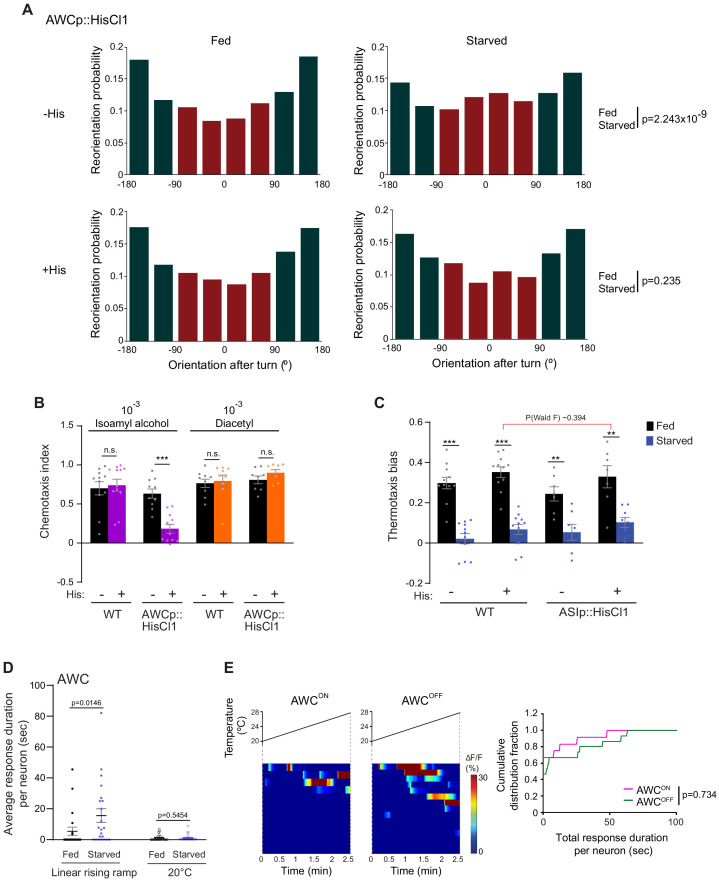
Inhibition of AWC temperature responses restores negative thermotaxis in starved animals.(A) Histograms of movement orientation following a turn in animals expressing HisCl1 in AWC in the absence or presence of histamine on the assay plate. Data are from Figure 2A. Tracks from 8 assays of 15 animals each were categorized into bins of 45°. Red and green bars indicate orientation toward the warmer/orthogonal or cooler side, respectively. p-values were derived using the Mardia-Watson-Wheeler non-parametric test for circular data. (B) Mean chemotaxis index of animals of the indicated genotypes to a point source of the odorants isoamyl alcohol or diacetyl. Chemotaxis index is defined as (number of animals at the odorant) – (number of animals at the control)/total number of animals. Assays were performed in the absence or presence of 10 mM histamine on the assay plate as indicated. Each dot represents a biologically independent assay of ~100 animals each. Errors are SEM. *** indicates different from fed (Student’s t-test); n.s. – not significant. (C) Mean thermotaxis bias of fed and starved wild-type and transgenic animals expressing HisCl1 in ASI under the srg-47 promoter in the presence or absence of 10 mM histamine on the assay plate. Each dot represents the thermotaxis bias of a biologically independent assay comprised of 15 animals. Errors are SEM. *** and ** indicate different from fed at each condition at p<0.001 and p<0.01, respectively (Student’s t-test). P-value in red indicates Wald F-statistic from linear regression analysis for the effect of the indicated genotype on the magnitude of the feeding state effect. Wild-type data were interleaved with experimental data in Figure 2A, and Figure 3F–G, and are repeated. (D) Average duration of individual calcium events per AWC neuron (dots) in fed and starved animals in response to a rising linear temperature ramp or a constant temperature of 20°C, derived from data shown in Figure 2C–D. Means are indicated by horizontal black lines; errors are SEM. p-value was obtained using the Mann–Whitney U test. (E) (Left) Intracellular calcium dynamics in AWCON and AWCOFF neurons in starved animals expressing GCaMP3 in response to a linear rising temperature stimulus (black lines) at 0.05 °C/s. AWCON and AWCOFF neurons were identified via the expression of srsx-3p::mScarlet in AWCOFF. Each row in the heatmaps displays responses from a single neuron from different animals ordered by the time of the first response; n = 12 (AWCON) and 15 (AWCOFF). (Right) Cumulative distribution fraction plots of total duration of calcium responses per AWCON and AWCOFF neuron calculated from data shown at left. Distributions were compared using the Kolmogorov-Smirnov test.Figure 2—figure supplement 1—source data 1.Source data for Figure 2—figure supplement 1.